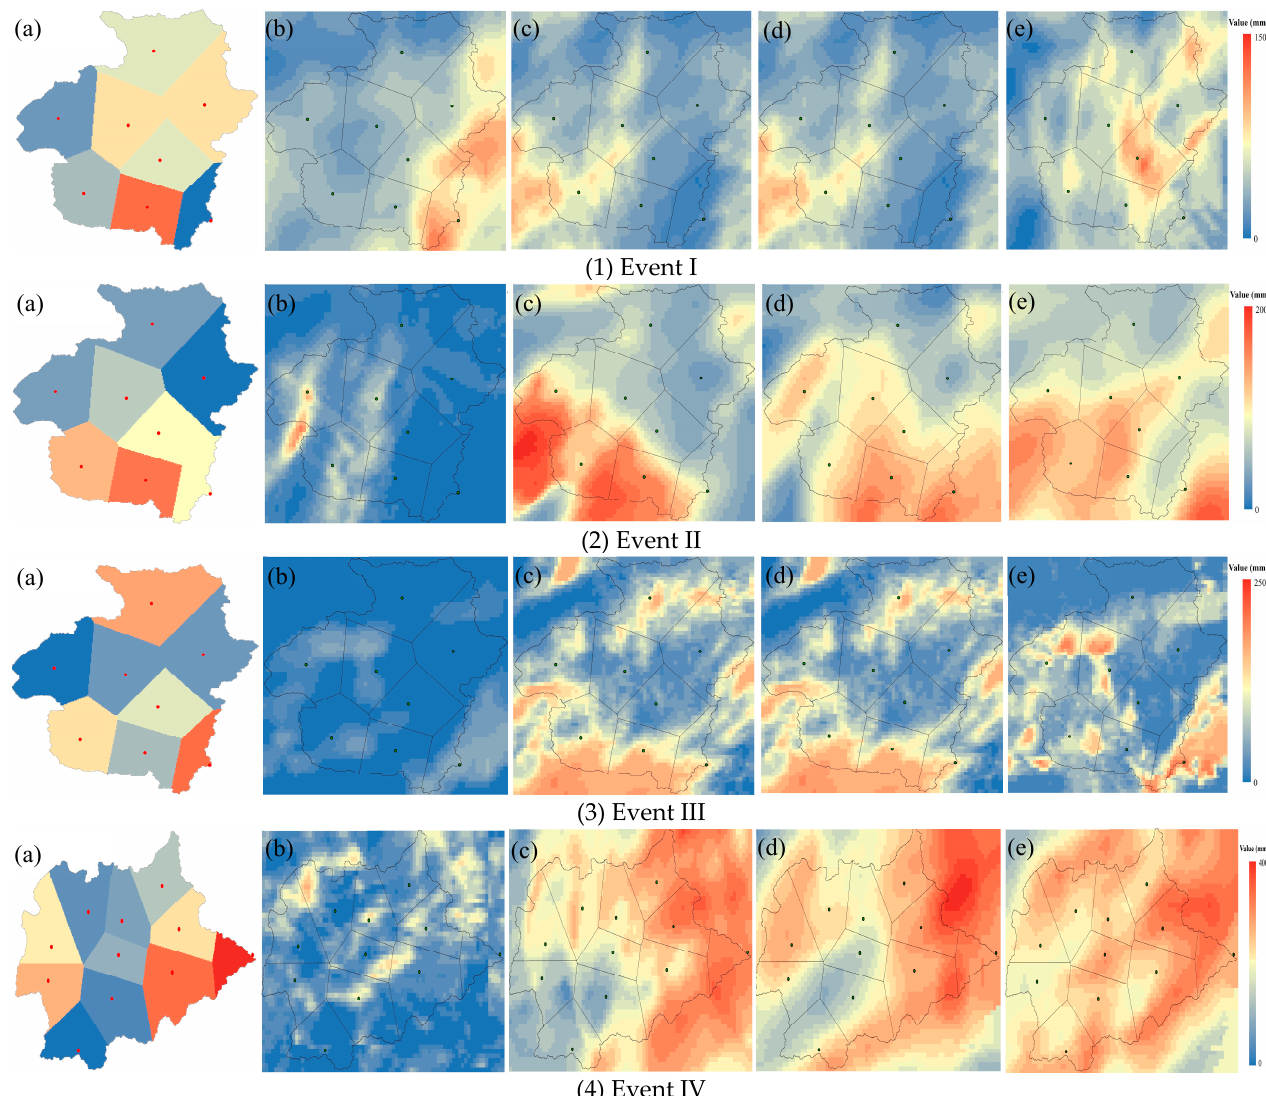
Figure 4. Spatial rainfall distributions of gauge observations and forecasts from four data assimilation schemes for Event Ⅰ , Ⅱ , Ⅲ , Ⅳ , from left to right: ( a ) observation; ( b ) NA_1km; ( c ) DA_1h_1km; ( d ) DA_1h_3km; ( e ) DA_6h_3km.